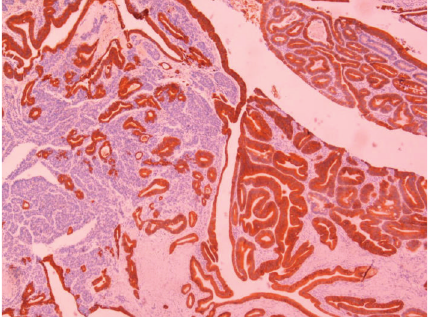
Figure 3: Mixed NET of the pancreas.